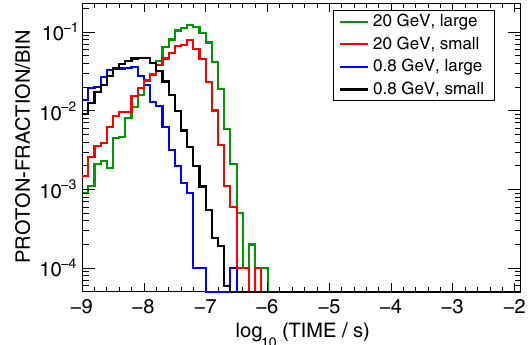
FIG. 6. Proton fraction as a function of the total time period the produced neutrons spend in the ion beam pipe. The simulations were carried out without a moderator. The distributions are shown for different proton energies and tungsten target sizes (see also Table II and the discussion of Eq. (1)). The x-axis has a logarithmic binning with ten bins per time decade.